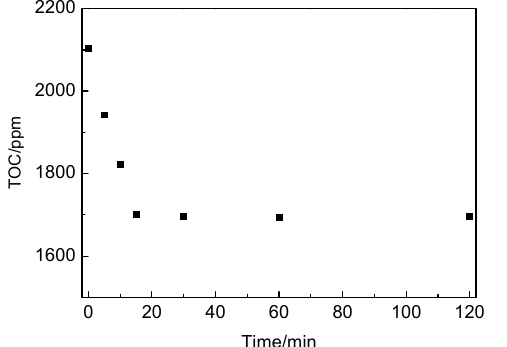
Figure 9. TOC content of the sucrose solution after nano-C-S-H gel were added for various time. (0.2 g sucrose dissolved in 36.2 g water, and then 4.0 g nano-C-S-H gel was added).